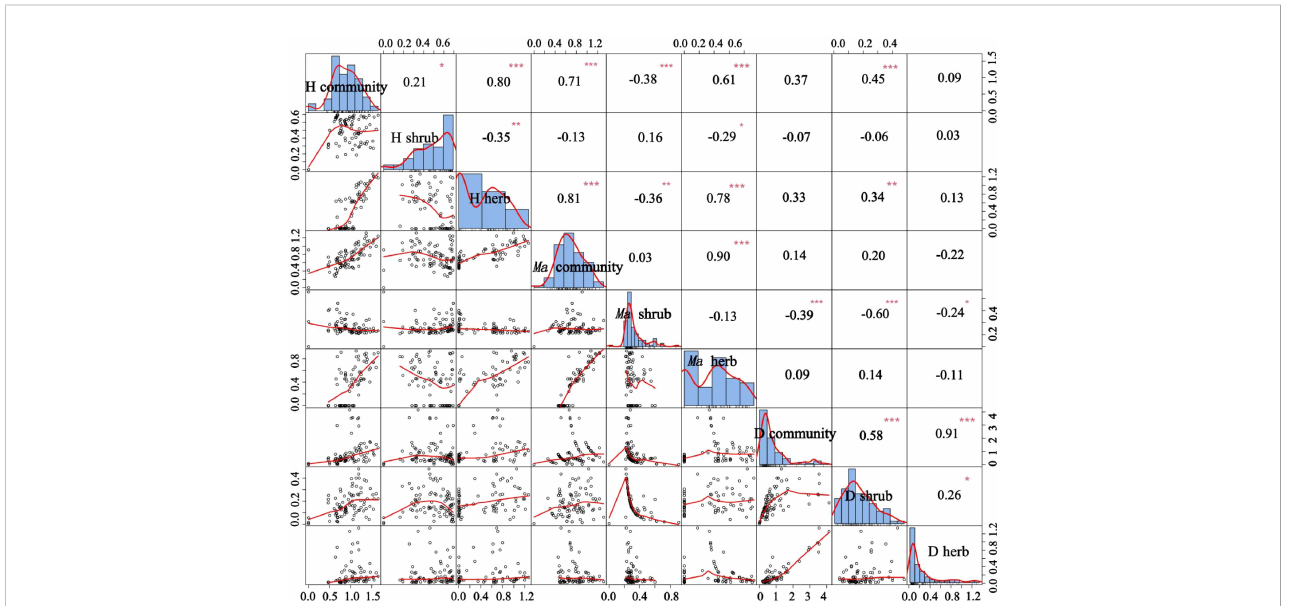
FIGURE 7 Relationship between community richness diversity and community density. H community, H shrub, and H herb represent the Shannon-Wiener diversity index of community, shrub layer, and herb layer; Ma community, Ma shrub, and Ma herb represent the Margalef richness index of community, shrub layer, and herb layer; D community, D shrub, and D herb represent the density of community, shrub layer, and herb layer. *P < 0.05, **P < 0.01, ***P <